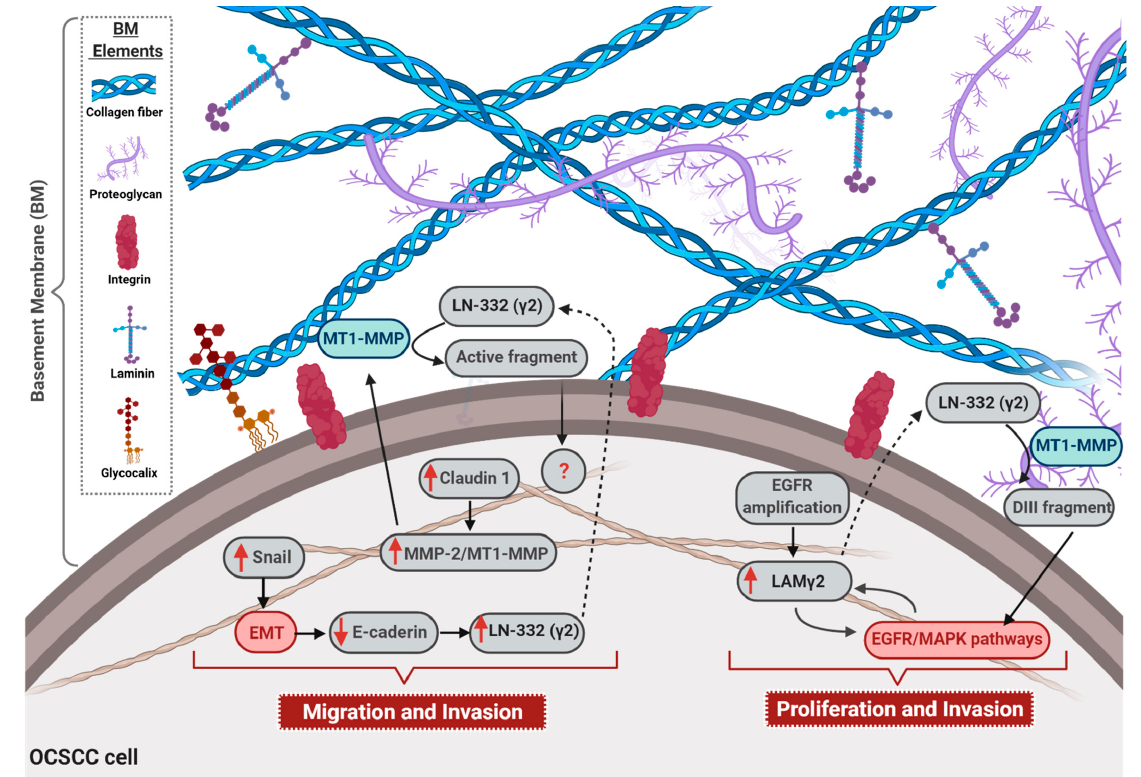
Figure 1. Role of laminin in oral cavity squamous cell carcinomas (OCSCC) progression. The figure illustrates the main mechanisms through which laminin is involved in OCSCC malignant phenotype acquisition. Up-regulation of the transcription factor Snail activates epithelial–mesenchymal transition (EMT), and consequently e-cadherin down-regulation, which enhances laminin 332 (LN-332) γ 2 chain expression. Additionally, overexpression of claudin-1 leads to an increase in the expression of matrix metalloproteinase 2 (MMP-2) and membrane type 1 (MT1)—MMP, as well as to the cleavage rate of LN-332 ( γ 2) by these proteases, culminating in the migration and invasion of OCSCC. Also, EGFR gene amplification is associated with overexpression of γ 2 chain (LAM γ 2) that, in turn, hyperactivates EGFR/MAPK signaling pathway and, in a feedback circuit, increases LAM γ 2expression. Moreover, the secreted LN-332 ( γ 2) is cleaved by MMP2 and MT1- MMP, generating the DIII fragment that can bind to EGFR, ending up in the activation of EGFR/MAPK pathway. Finally, the activation of EGFR/MAPK signaling pathway enhances proliferation and invasion rates of OCSCC cells. Dotted ar- rows: molecules secreted by OCSCC cells; solid arrows: activation of cellular events or intracellular signaling pathways; red solid arrow: overexpressed molecules; red boxes: activated signaling pathways; blue boxes: cleavage by MT1-MMP. BM = basement membrane.